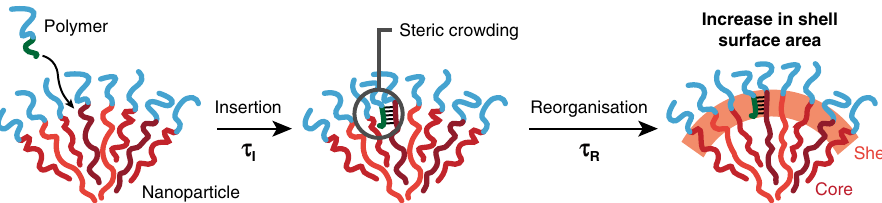
Fig. 5 Illustration of the polymer insertion process in MORPH. The polymer inserts with timescale τ I into a thin shell region at the core – corona interface. Insertion causes steric crowding that must be relieved by reorganisation to increase the shell ’ s surface area, which proceeds with timescale τ R .